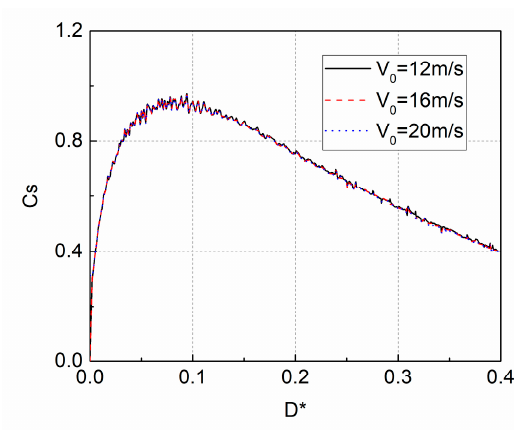
Figure 10. Variations of the non-dimensional impact force with different impact velocities.